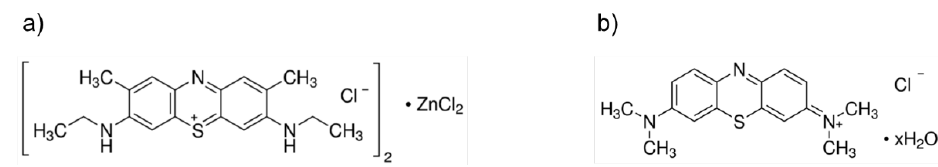
Figure 1. Chemical structures of the photosensitizers used in the study: ( a ) New Methylene Blue; and ( b ) Methylene Blue.